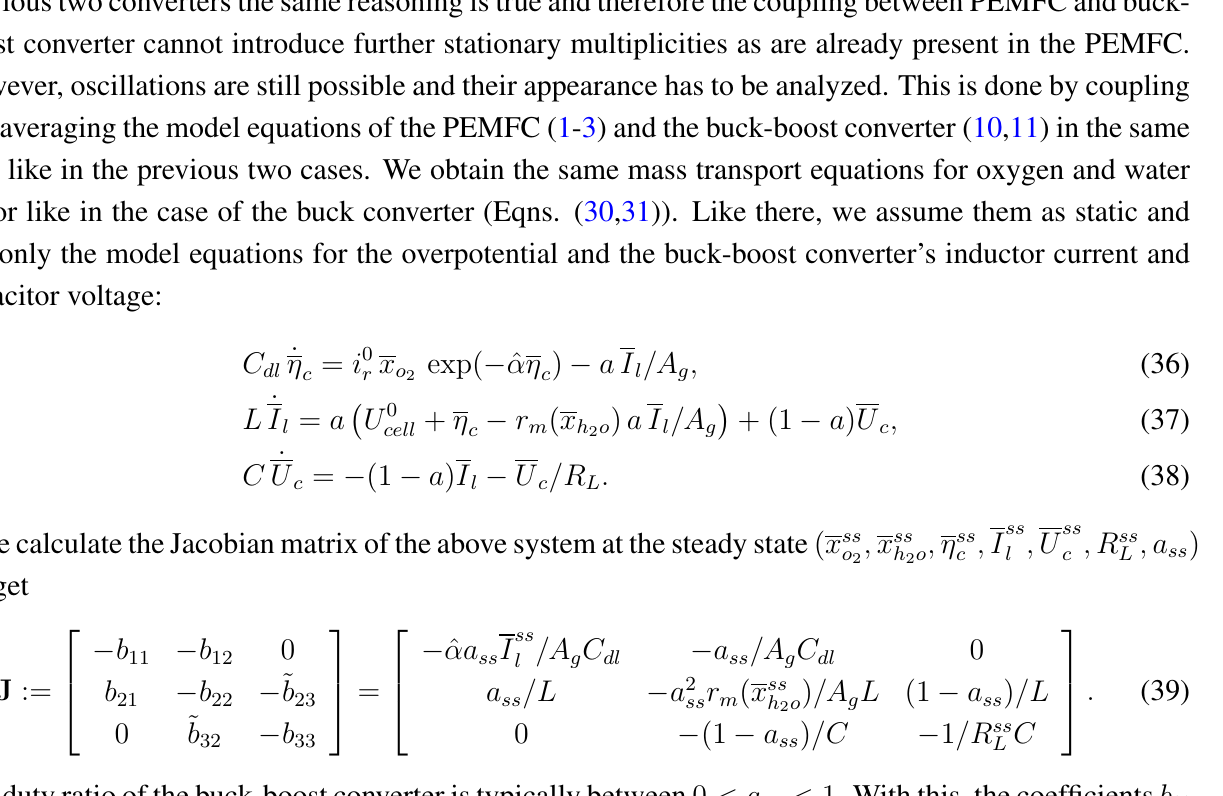
Figure 17. Stationary oscillation amplitudes ∆ η buck-boost converter’s duty ratio a at different values of ˆ α . The quantity a ( P the duty ratio at the maximal cell power P